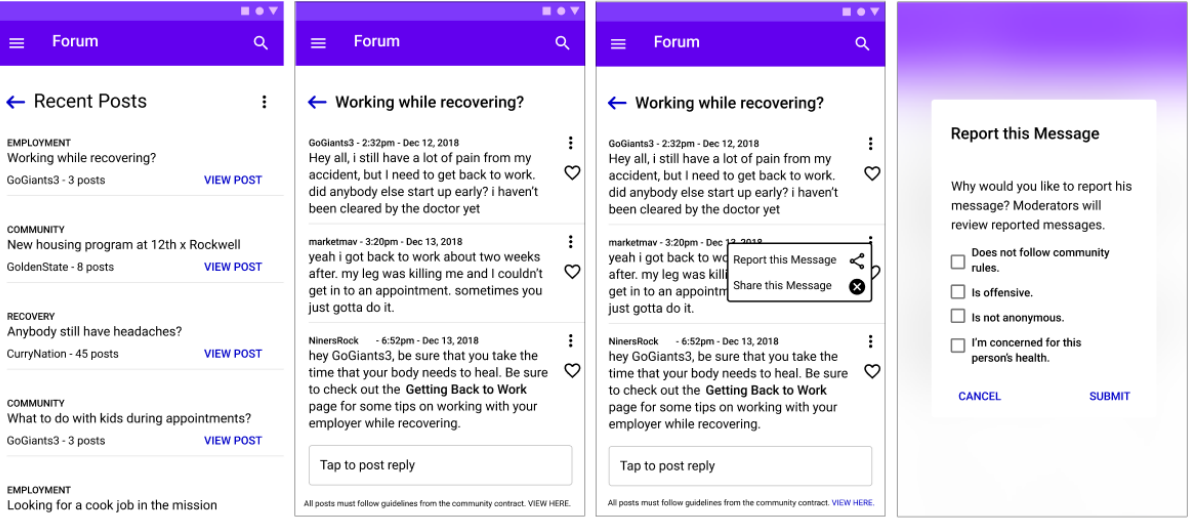
Figure 6. Proposed depiction of a community forum and/or social network for clients to share resources and experiences with peers in an anonymous environment. The last screen depicts a reporting mechanism within the application to ensure safe interactions between clients within the